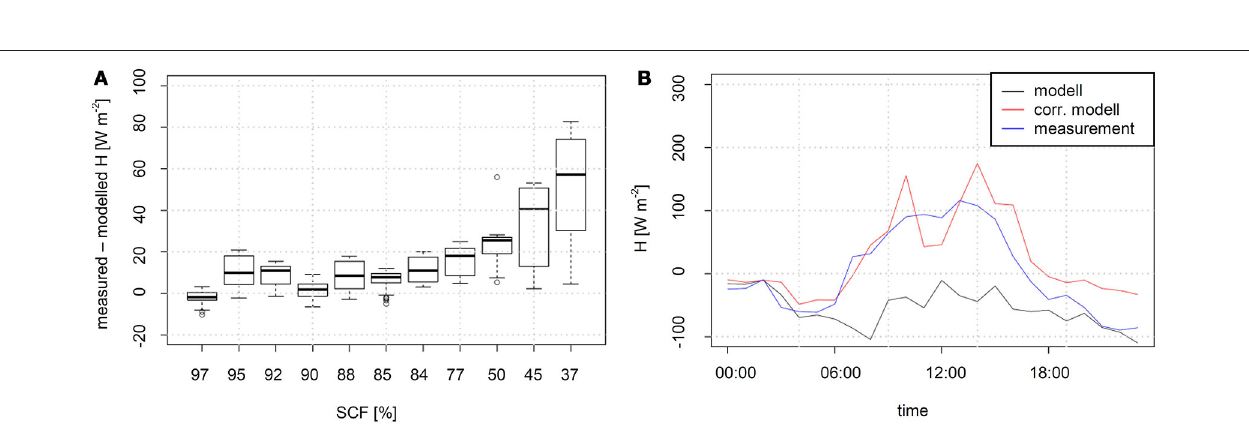
FIGURE 8 | Difference between modeled surface turbulent sensible heat fluxes and measured turbulent sensible heat fluxes in 2m above the surface [W m − 2 ] at the eddy-covariance tower as a function of snow cover fraction (SCF) [%] (A) . Turbulent sensible heat fluxes ( H ) for 18 May 2015 (SCF = 37%) at the eddy-covariance tower (B) . The eddy-covariance measurement in 2m above the surface is shown in blue, Alpine3D surface turbulent sensible heat flux is shown in black, turbulent sensible heat flux in 2m above the surface after applying the flux footprint approach is shown in